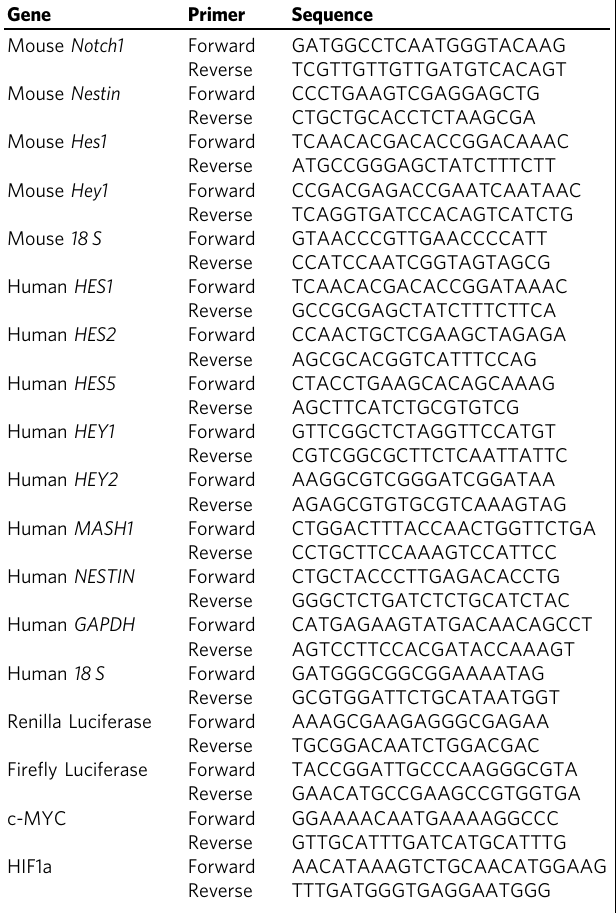
Table 1 Primers used in this